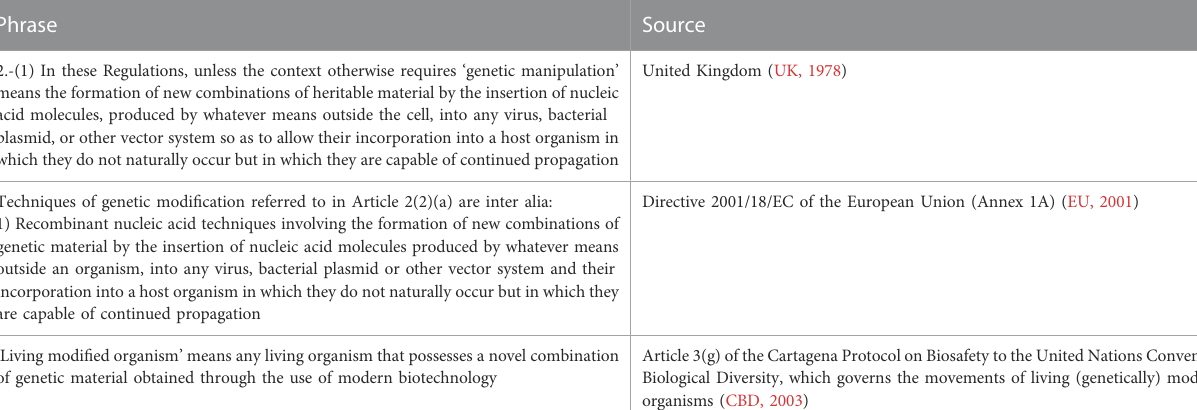
TABLE 1 Phylogeny of regulatory trigger phrases. Phrase